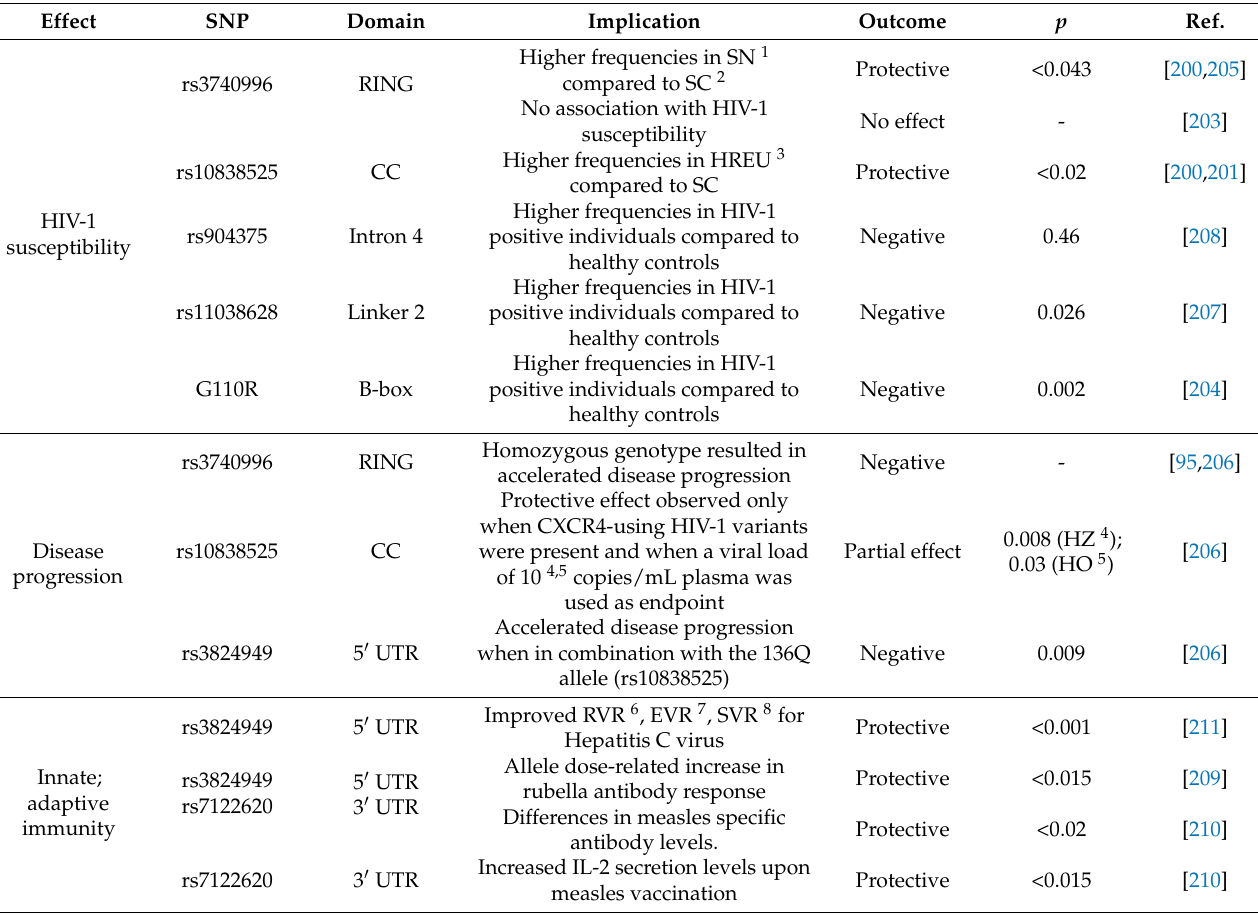
Table 1. Association between hu TRIM5 SNPs and HIV-1 susceptibility, disease progression, and